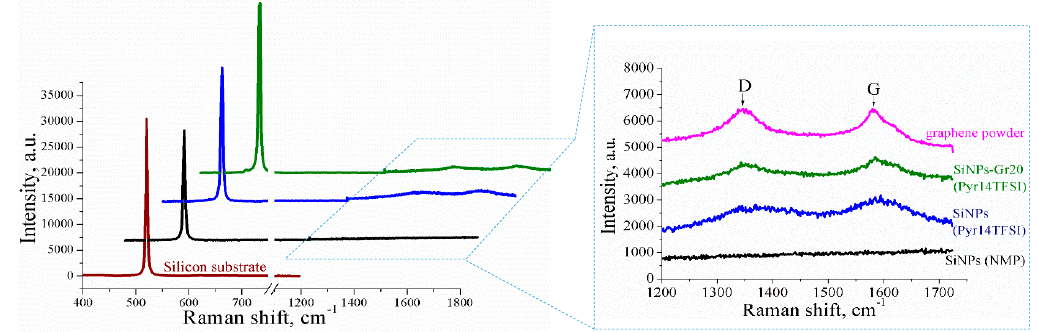
Figure 5. Raman spectra of SiNPs (NMP), SiNPs (Pyr14TFSI), and SiNPs-Gr20 (Pyr14TFSI) layers, with a detailed focus on the 1200–1750 cm − 1 range.